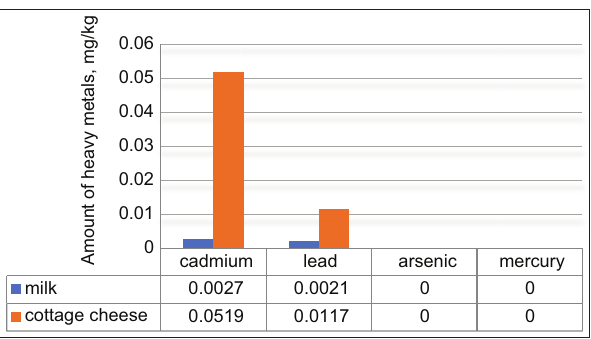
Figure-1: Comparative data regarding the heavy metal contents in the milk and cottage cheese samples.